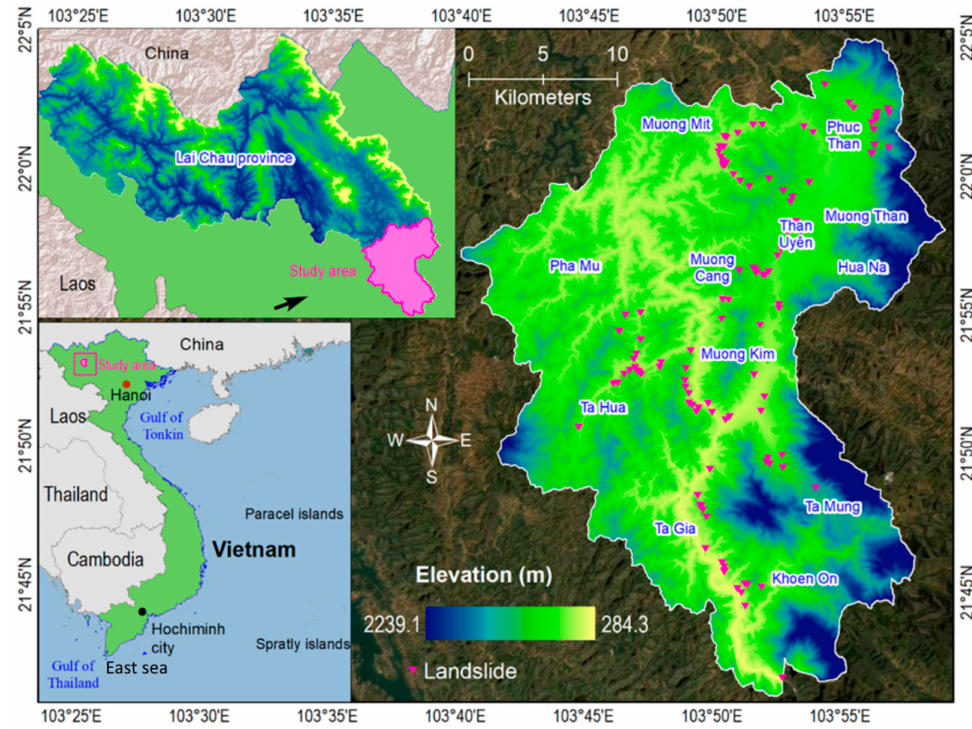
Figure 1. Location of Than Uyen